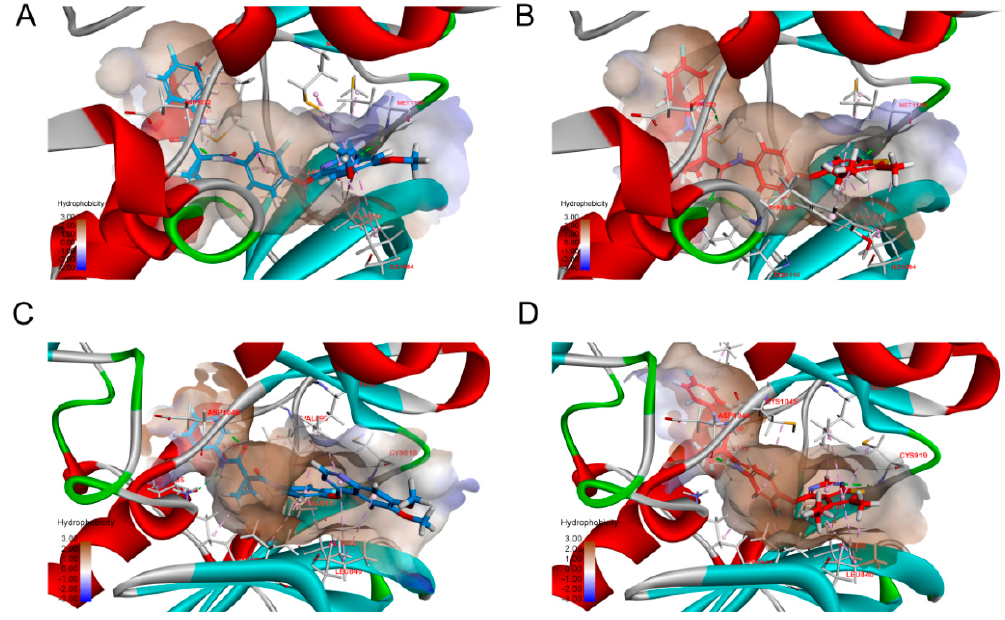
Figure 3. Binding poses of compound 13b ( A , C ) and 13h ( B , D ) with c-MET and VEGFR2. Compound 13b and 13h were displayed by blue and red, respectively. The important residues and their critical interactions (dash lines) with compounds in the binding site were depicted, hydrogen bond, hydrophobic interactions were colored green and carnation, respectively.